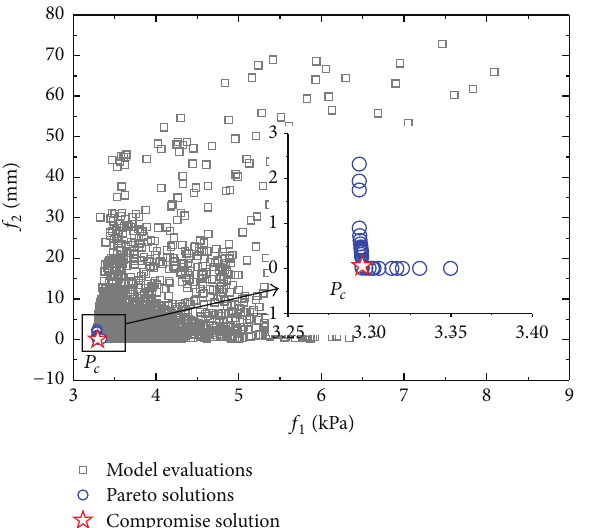
Figure 13: Normalized range of optimal parameter values for the soil